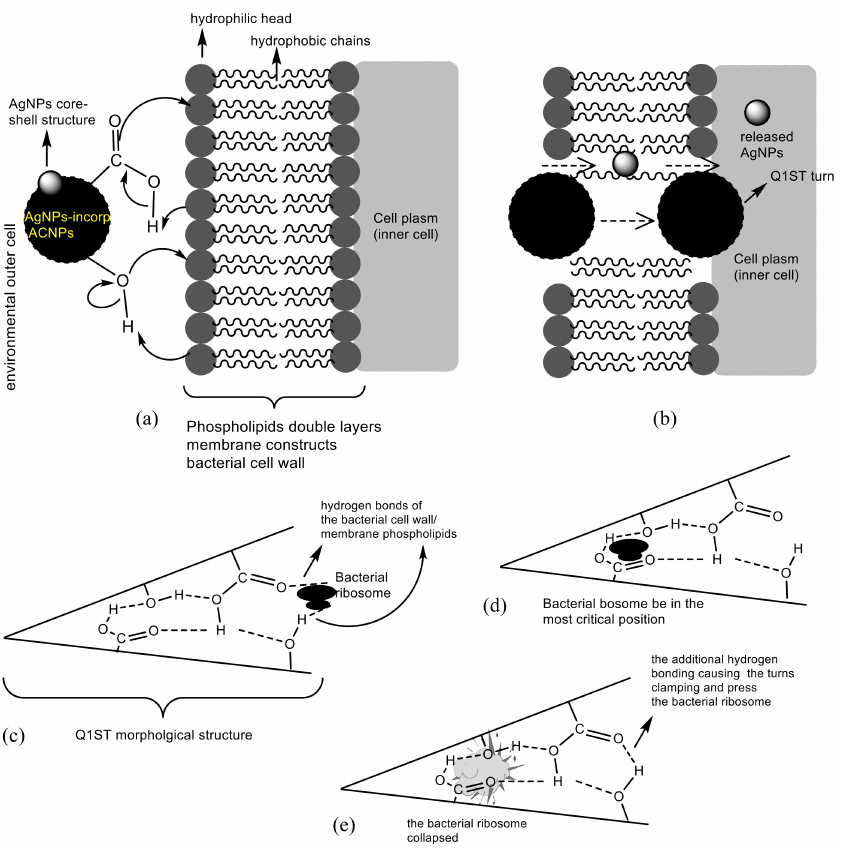
Figure 3. Schematic illustration of ( a , b ) entering process of AgNPs-immobilized ACNPs to the bacte- rial cell plasm; ( c – e ) the role of ACNPs Q1ST turn in the synergistic effect of the synthesized AgNPs.